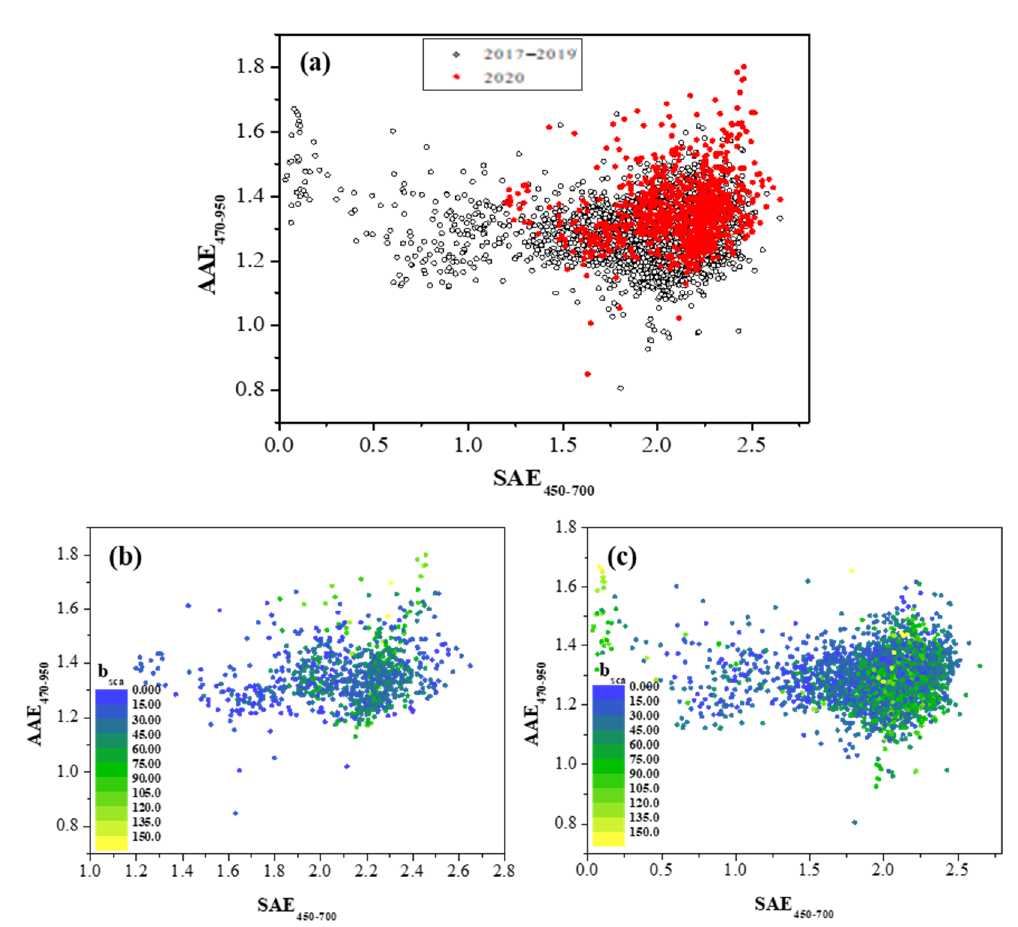
Figure 10. Correlation between SAE and AAE values during the period 23 March–3 May for the years 2017–2019 and for 2020 ( a ), and as a function of the b sca,550 (color scale) for the same periods in 2020 ( b ) and for 2017–2019 ( c ).